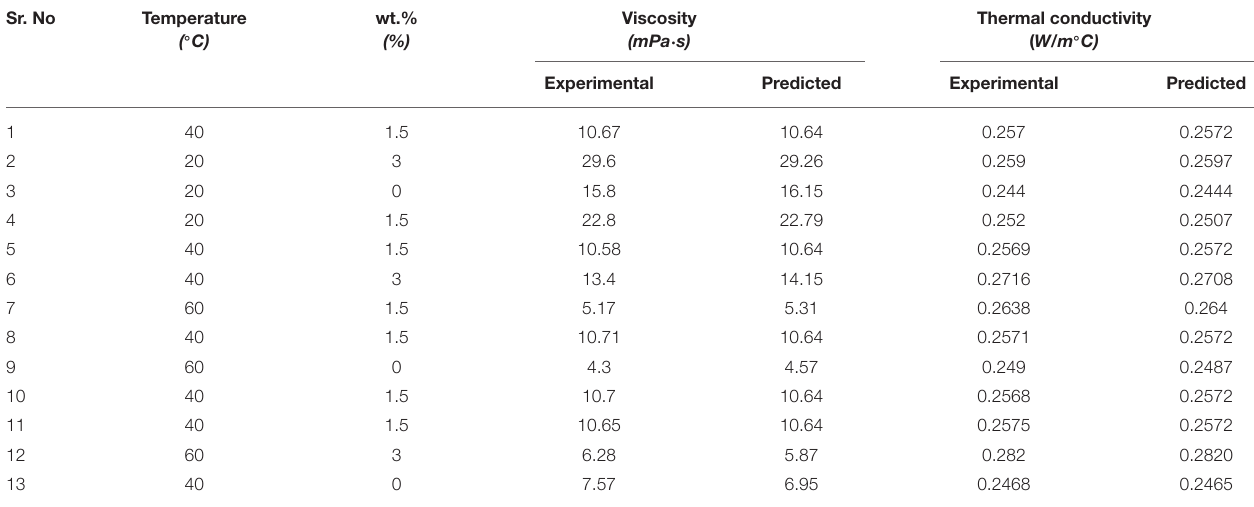
The experimental data were acquired from Sundar et al. (2014b).